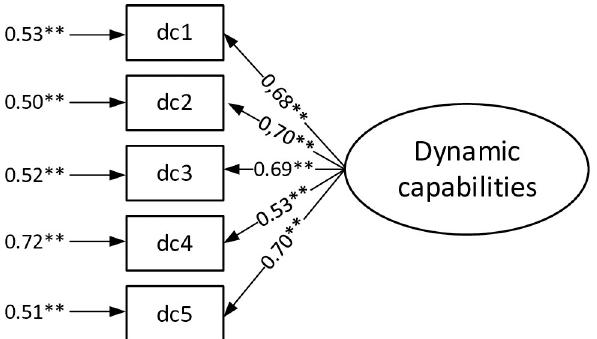
Fig 2. Confirmatory factor analysis for the measurement model of dynamic capabilities for the higher order indicator (factor loadings and error variance). Source: Own study.